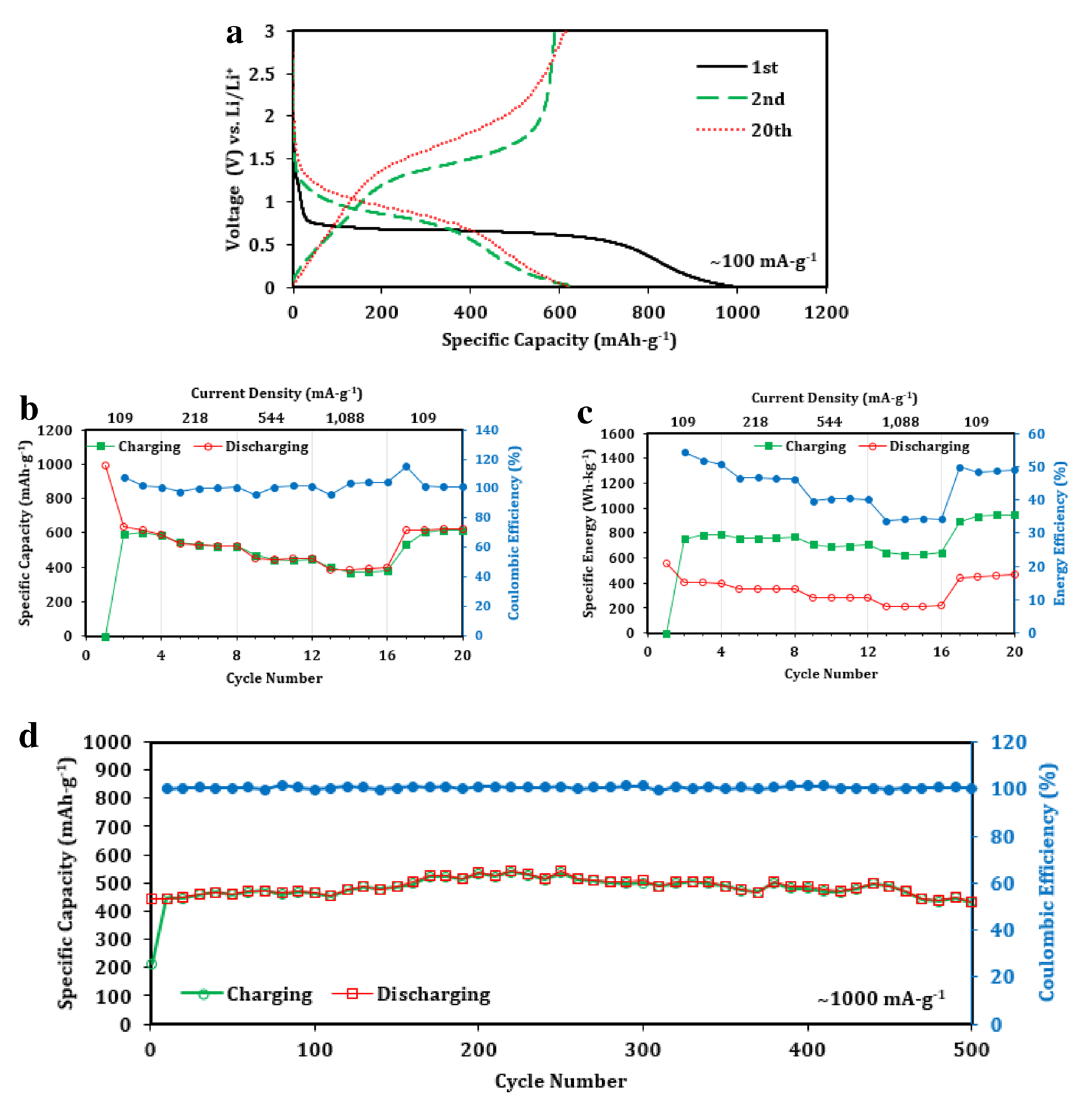
Figure 6. Electrochemical performance of best-performing porous CaFe 2 O 4 anode ( ϕ = 1.325, 900 °C calcination): ( a ) galvanostatic charge–discharge curves of 1st, 2nd, and 20th cycles at a current density of 109 mA-g -1 ; ( b ) rate performance in specific capacity; ( c ) rate performance in specific energy; ( d ) cycling stability at 1088 mA-g -1 up to additional 500 cycles after initial 20 cycle rate performance. Expectedly large initial efficiencies are omitted for clarity (Figure